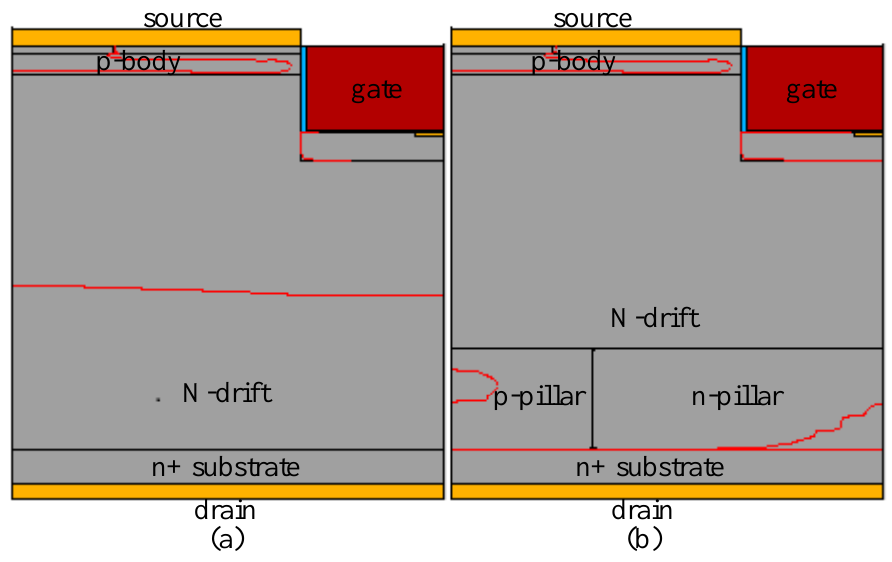
Figure 10. Depletion distributions of ( a ) C-UMOS and ( b ) BSJ-UMOS at V ds = 70 V and V gs = 0 V.